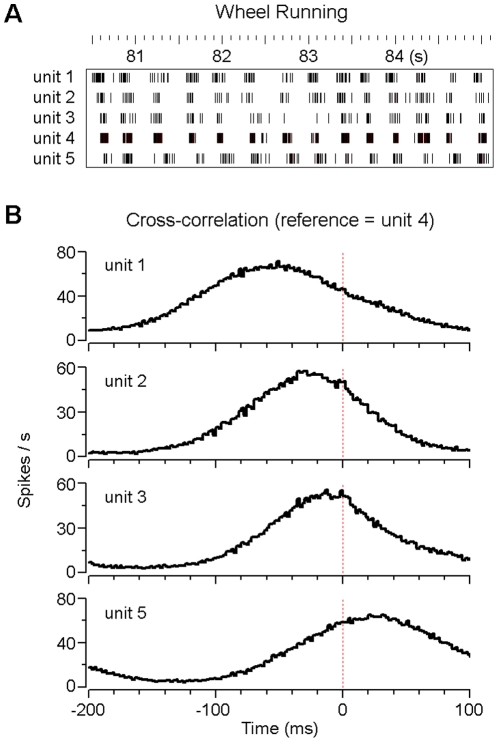
Phase-specific firing of VTA non-DA neurons during wheel running.(A) Rasters of five simultaneously recorded VTA non-DA neurons during voluntary wheel running. (B) Cross-correlation histograms show that the same five neurons (as shown in A) fire preferentially at specific phases of each cycle and in sequence during voluntary wheel running (unit 4 was used as the reference for cross-correlation calculation).